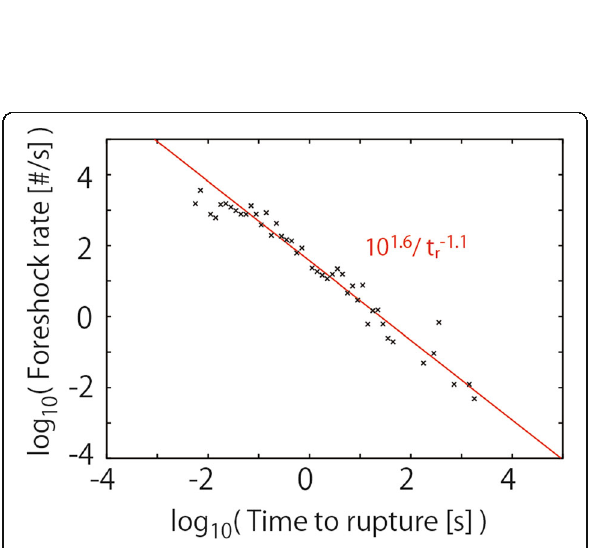
Fig. 8 Foreshock rates following an inverse Omori law. Foreshock rates measured for the stacked sequence in parameter set B are shown against the time remaining before the mainshock. The red line denotes the fitted power law function. Estimated parameters are shown in the plot with red